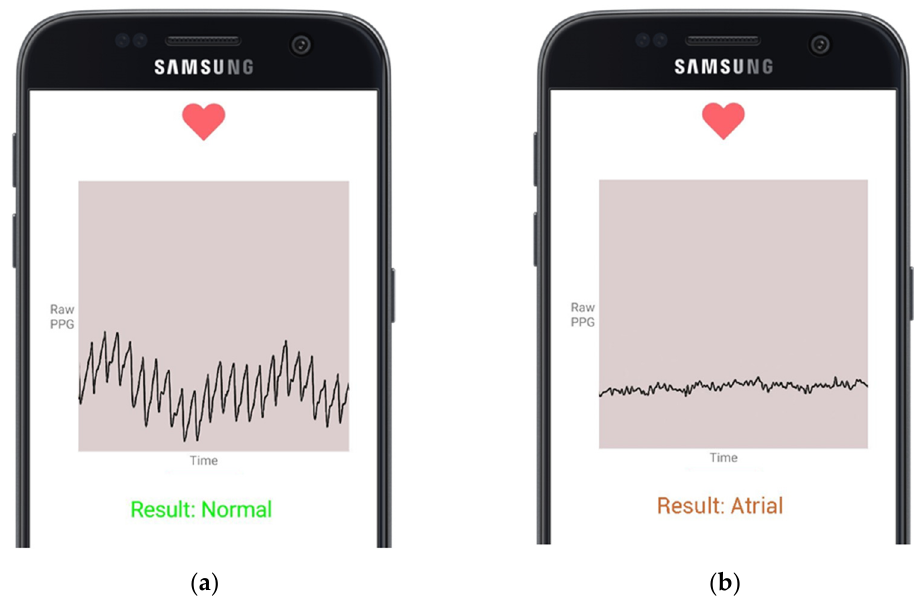
Figure 7. Cardiac arrythmia classifications presented on a smartphone application by the model using live PPG readings from the fingertip smartphone sensor; ( a ) presents NSR Classification; ( b ) presents AF Classification.